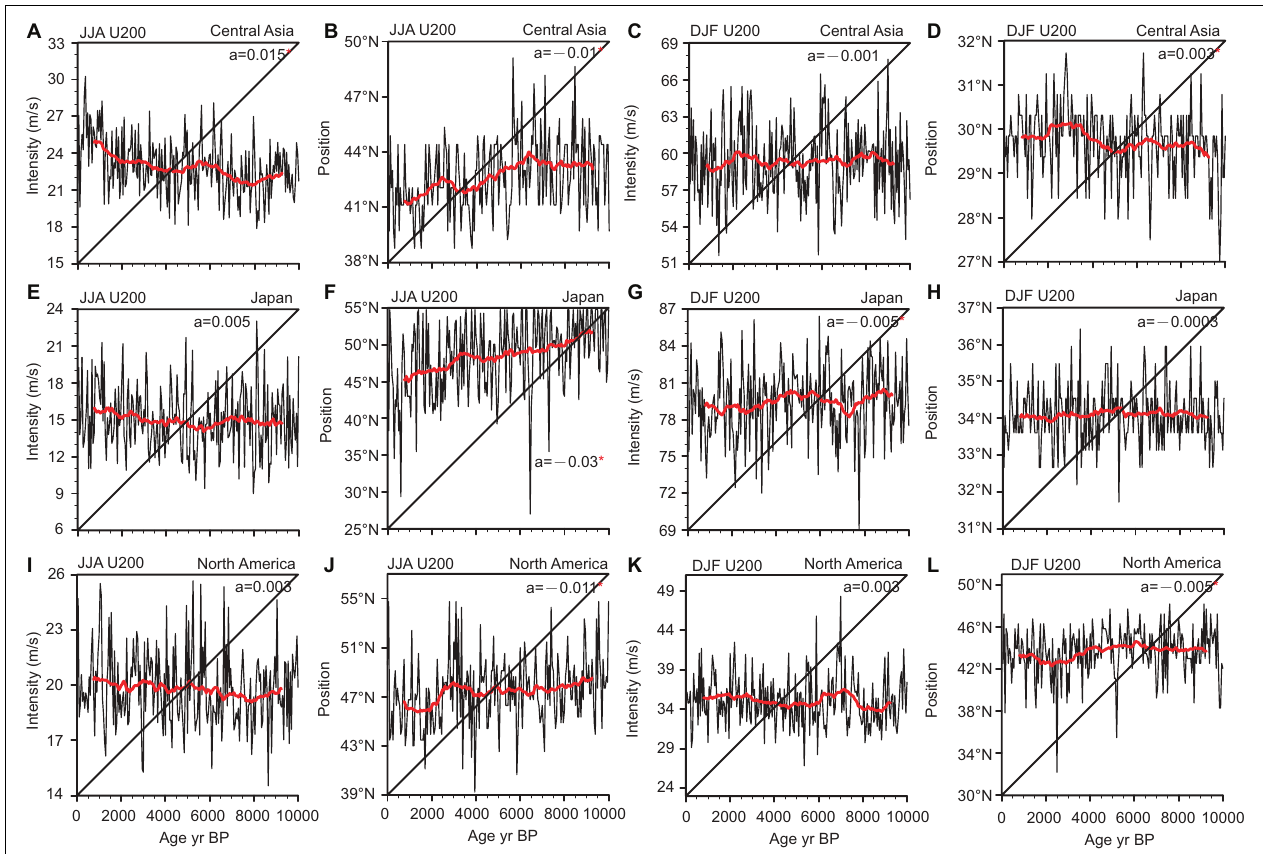
FIGURE 3 | Simulated changes in the intensity and position of WJ during the Holocene over Central Asia (a–d) , Japan (e–h) , and North America (i–l) . The red line represents a 31-simulation-year moving average. The red pentagram indicates that slope is significant at the 99% significance level.